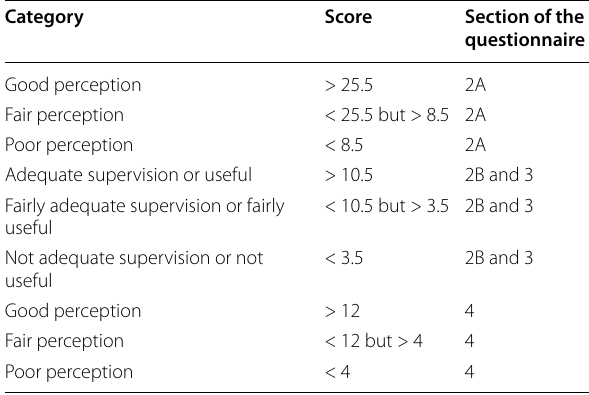
Table 1 Cut-off generated from 75th and 25th percentile